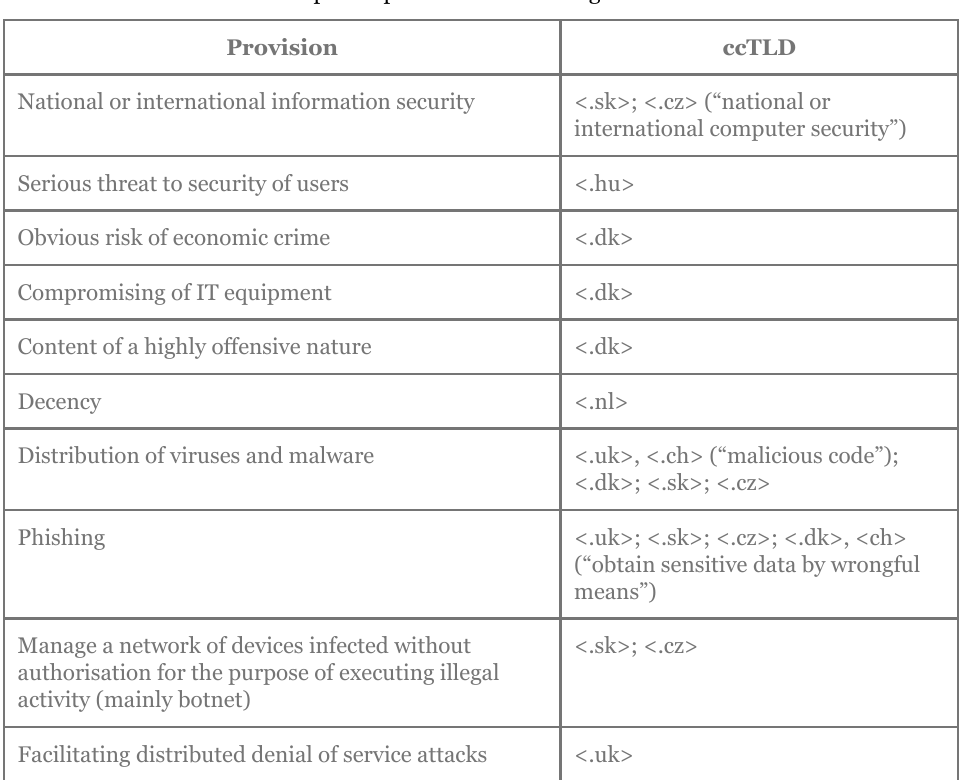
Table 2: Specific provisions addressing use or